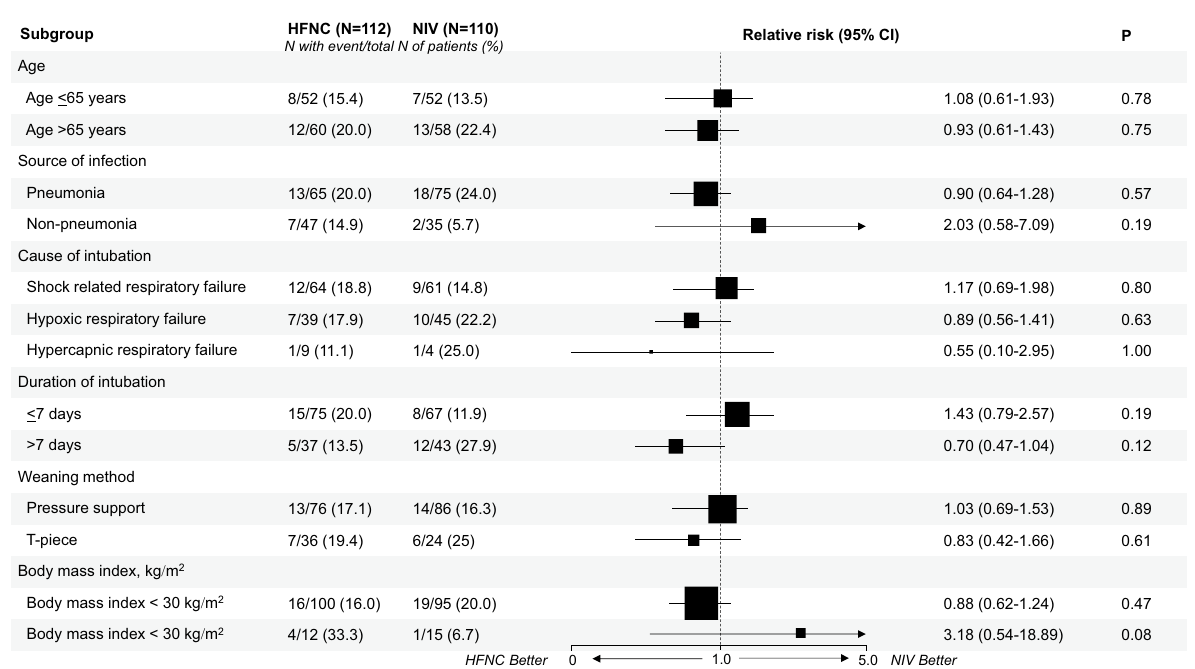
Table 3 Duration of device usage and causes of reintubation Variables Duration of device usage, median (IQR),